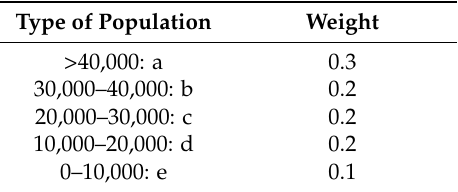
Table 8. Population-normalized weight